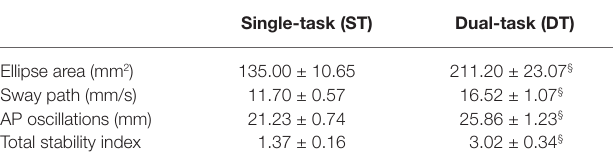
TABLE 1 | Results of the postural balance parameters in the single and dual- task